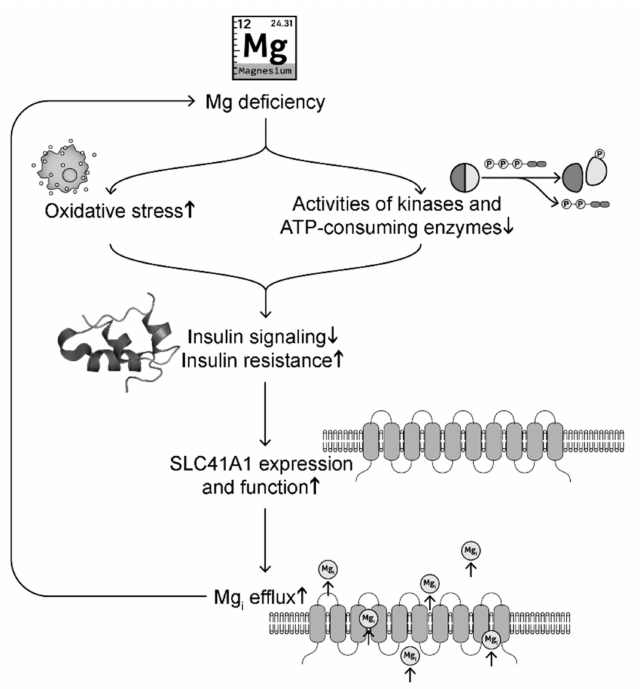
Figure 4. A possible signaling pathway linking intracellular Mg deficiency and insulin resistance in a positive feedback